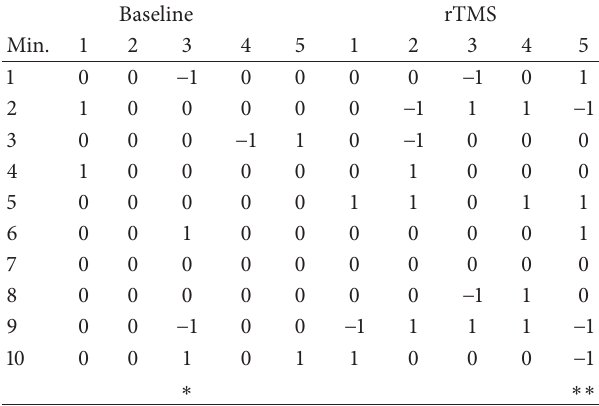
Table 2: Influence of rTMS upon the slope of consecutive 𝑅𝑅 intervals during each minute of baseline and rTMS